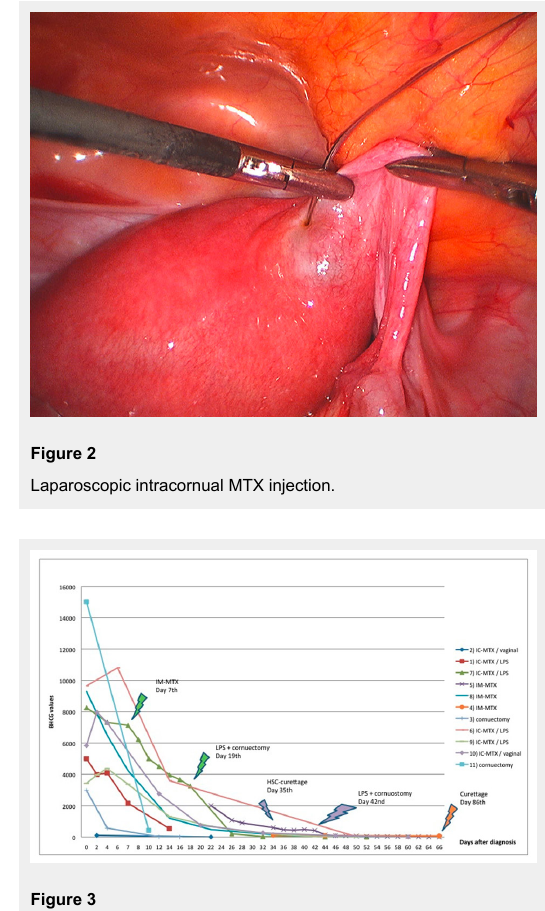
TVUS sagittal image showing an eccentric GS, blue arrow, surrounded by a thin myometrial layer, red arrow.